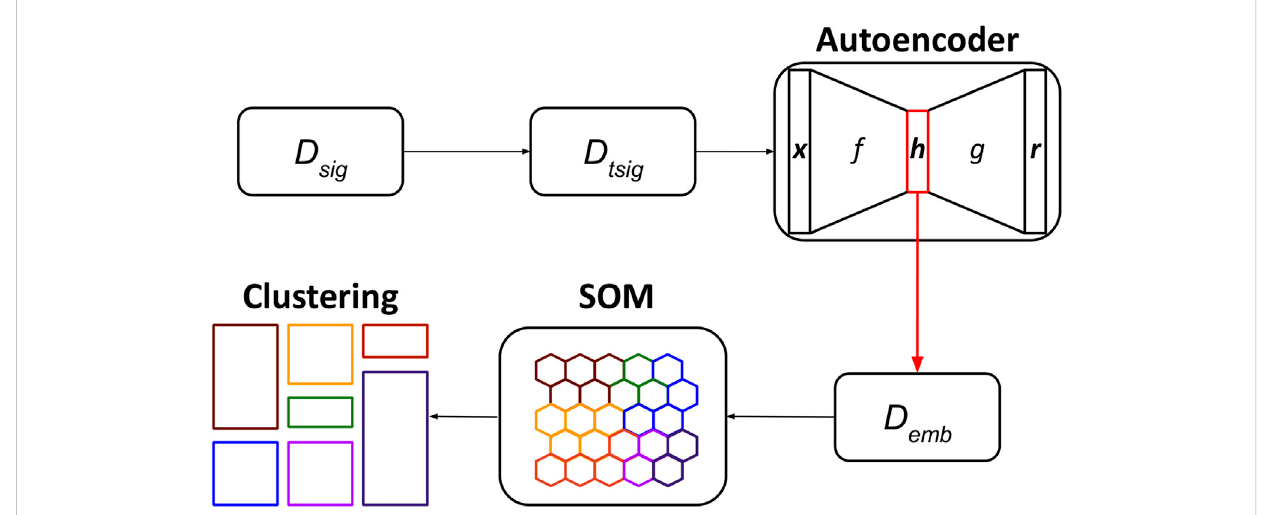
FIGURE 4 Work fl ow of the UNPLEX. The dataset containing ONT-like signals ( D seq ) is pre-processed to achieve a dataset of signals of the same length ( D tsig ), which are fed to the autoencoder to obtain their latent representations ( D emb ). The data included in dataset D emb are processed by the SOM, whose outcome is fi nally clustered, resulting in the classi fi cation of ONT-like signals according to their